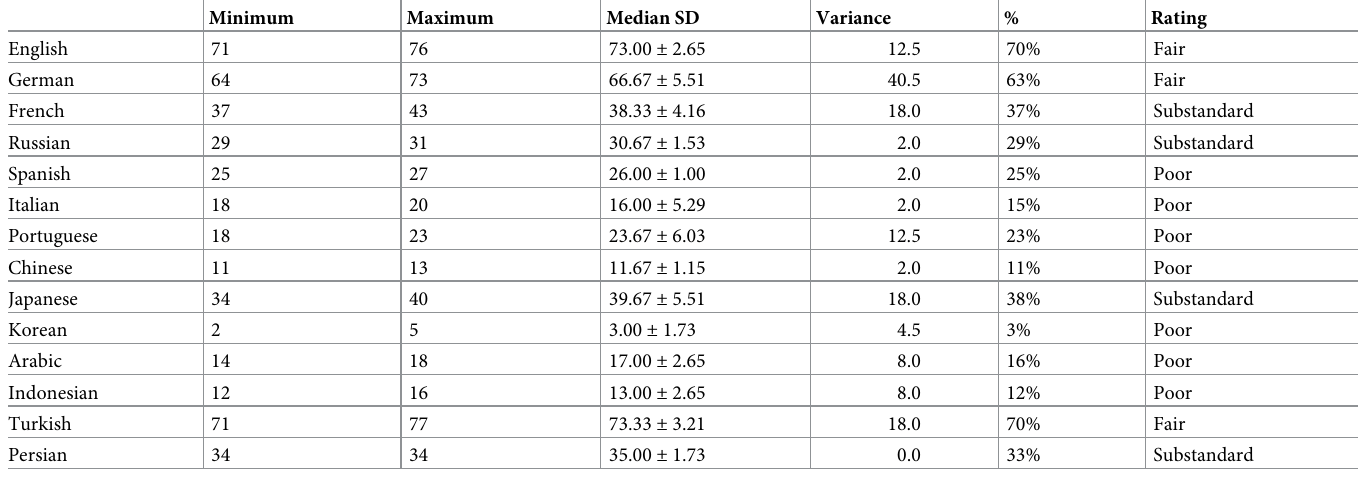
Table 1. Scores by